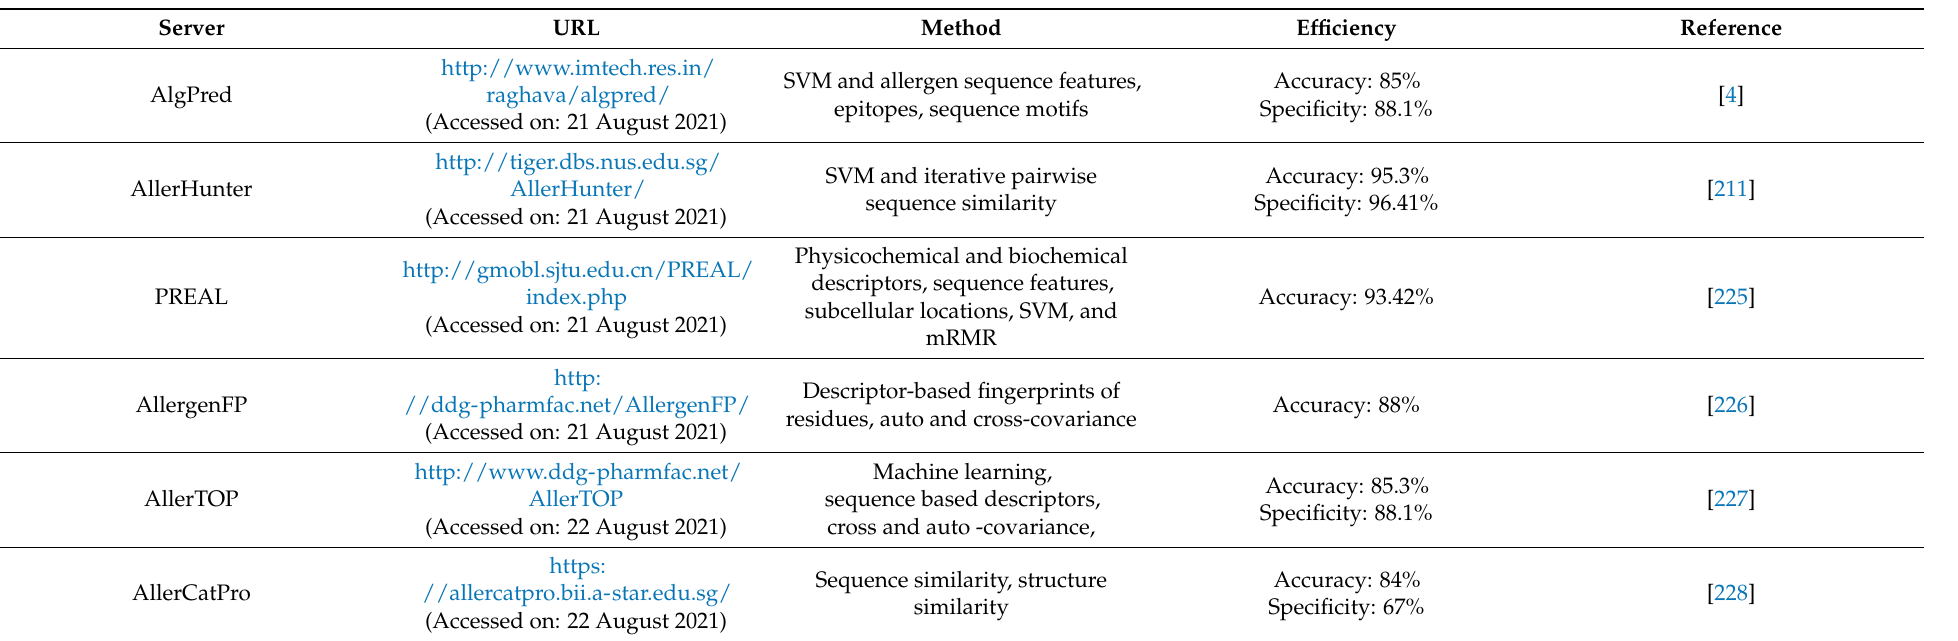
Table 3. Tools/servers for allergen/allergenicity